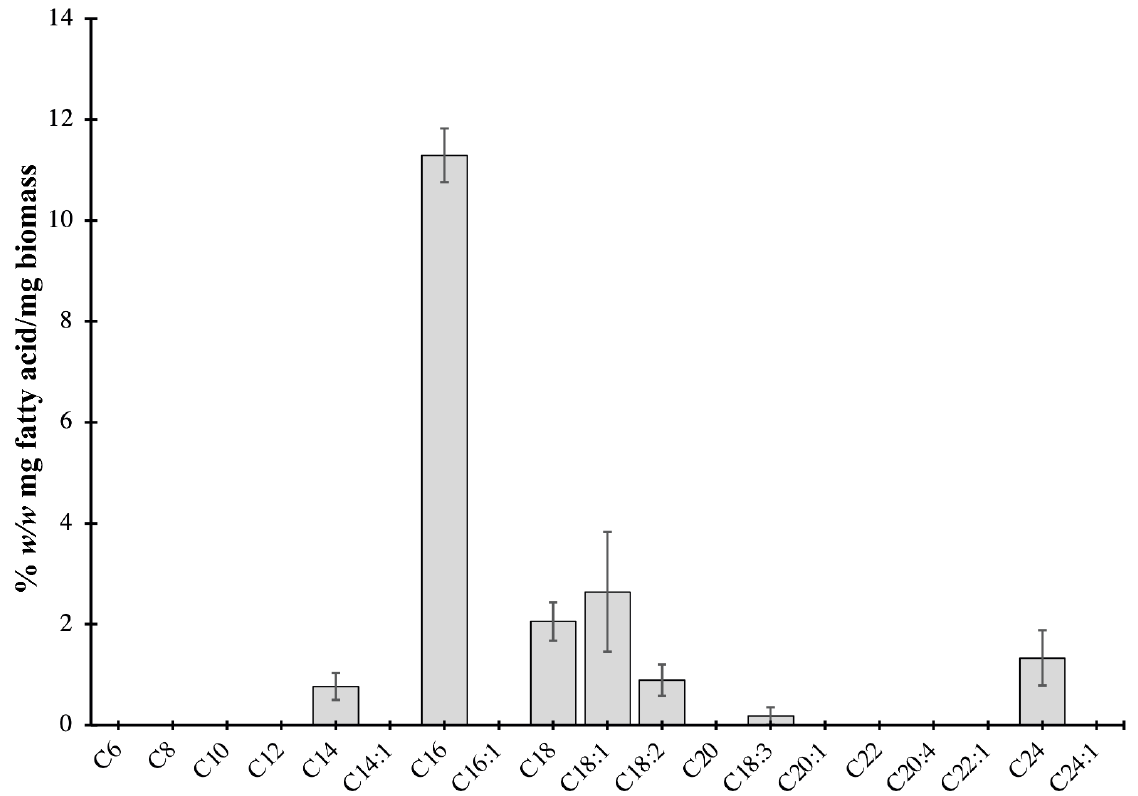
Figure 6. Fatty acid content of crude lipid extracts of P. bahamense. Saturated fatty acids (83.57% of crude lipid extract) were the major fatty acids in P. bahamense . These include palmitic acid (C16, 62.7%) and stearic acid (C18, 10.3%). Other fatty acids in P. bahamense include monounsaturated fatty acids (11.67%) such as oleic acid (C18:1, 14.3%) and polyunsaturated fatty acids (4.76%). Lipids were extracted using the Bligh–Dyer method, converted to the corresponding fatty acid methyl esters, and analyzed by gas chromatography–flame ionization detector (GC-FID). Data are shown as mean ± SD of two biological replicates with three technical replicates each.